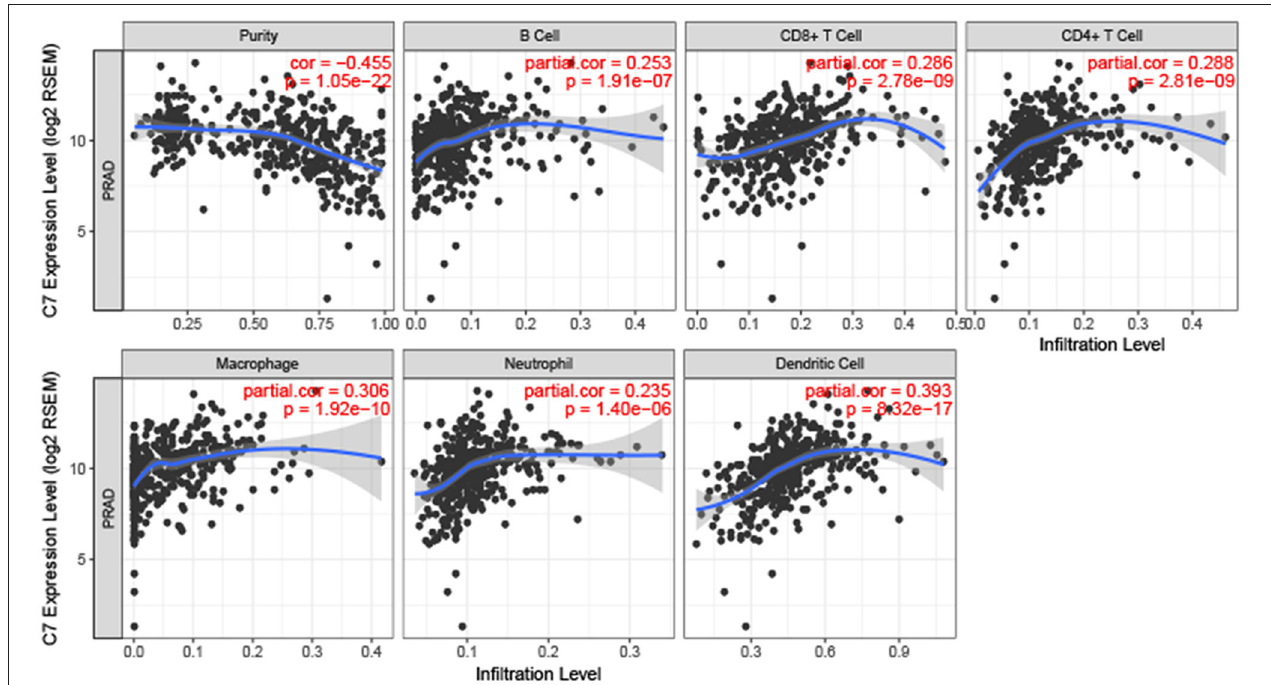
FIGURE 8 | Correlation of C7 expression with immune infiltration level in PC. C7 expression was positively related to macrophages and dendritic cells meanwhile negatively associated with tumor purity.